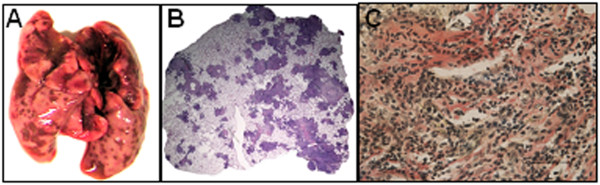
 Pulmonary pathology in M. tuberculosis infected guinea pigs. The figure depicts (A) representative photograph showing gross pathology of lungs of M. tuberculosis infected guinea pigs at 10 weeks post-infection; (B) lower magnification photomicrograph of H&E stained, formalin fixed and paraffin embedded 5 μm section of lung tissue exhibiting multiple coalescing granulomas with central necrotic core and (C) photomicrograph (at 40X) of Van Gieson stained 5 μm lung section exhibiting extensive fibrosis as evident from thick bands of collagen (red color) around the granulomatous regions. Scale bar represents 1000 μm.